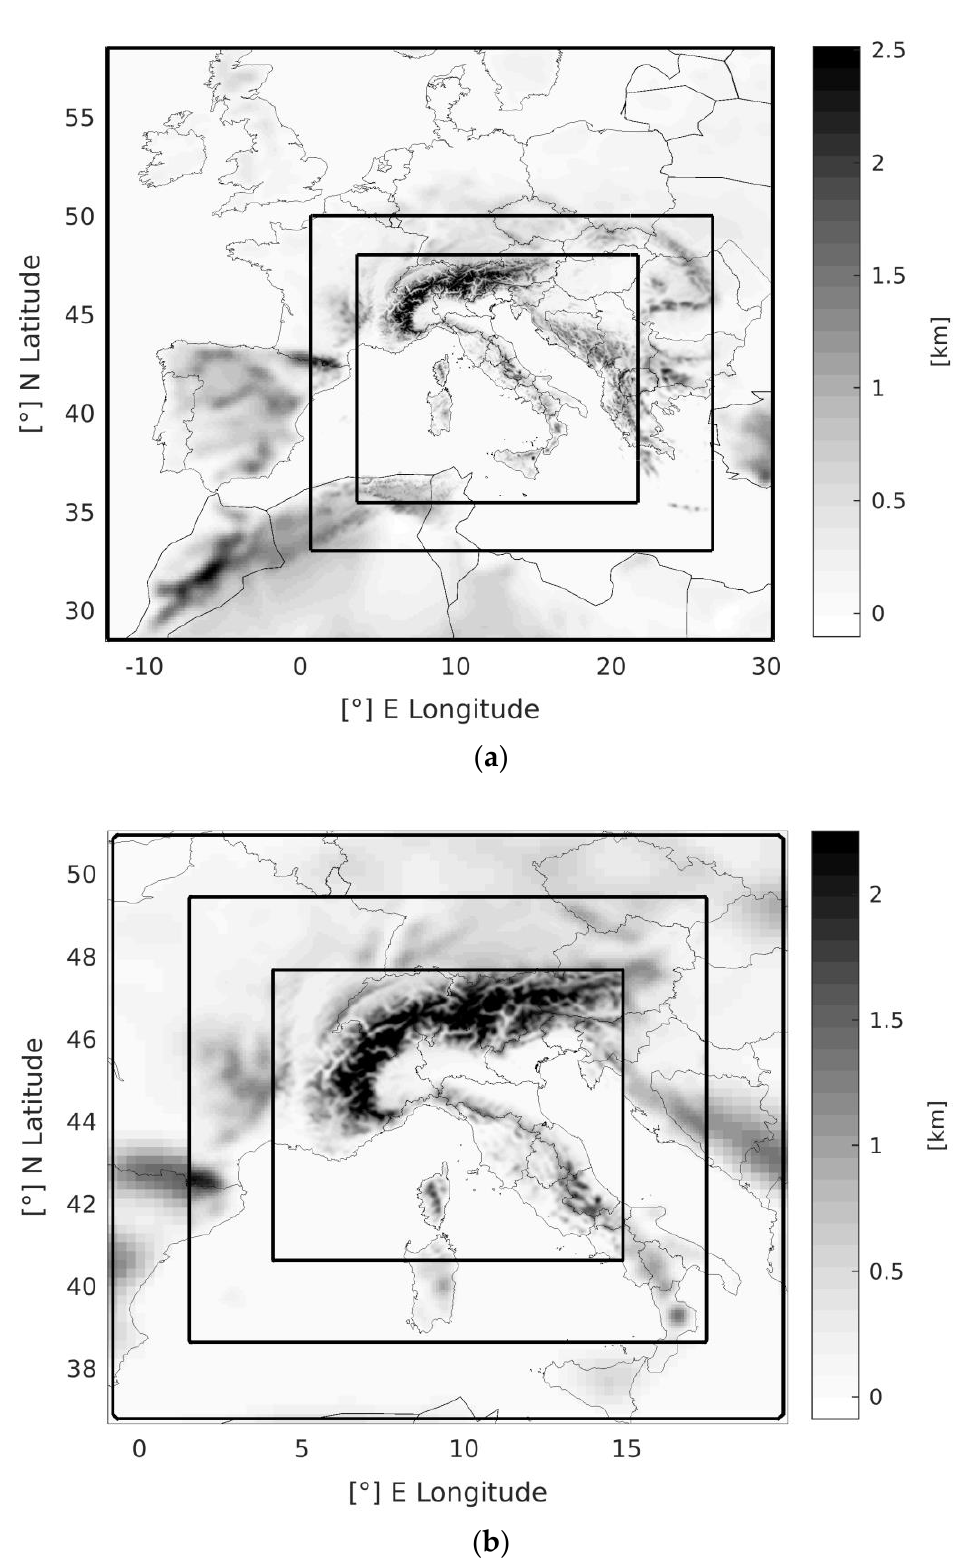
Figure 2. The Weather Research and Forecasting (WRF) domains used in the simulations ( a ) without and ( b ) with data assimilation. and ( b ) with data